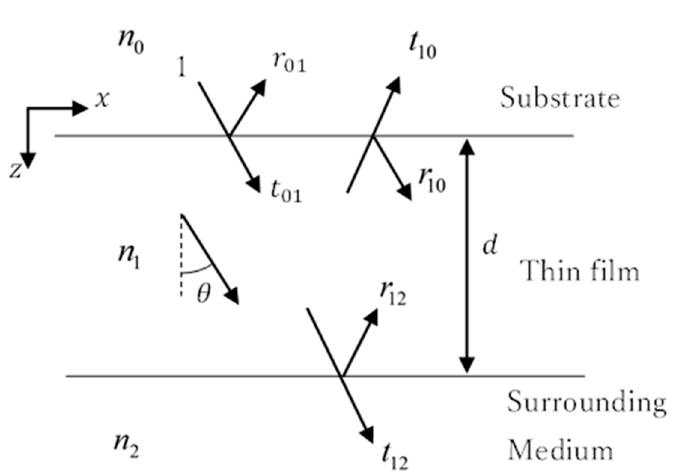
Figure 1. Schematic of SCCPA with substrate 0, thin film 1, and surrounding medium 2. Collimated white light incident from the side of the substrate enters the thin film and is totally reflected at the interface between the thin film and the surrounding medium.